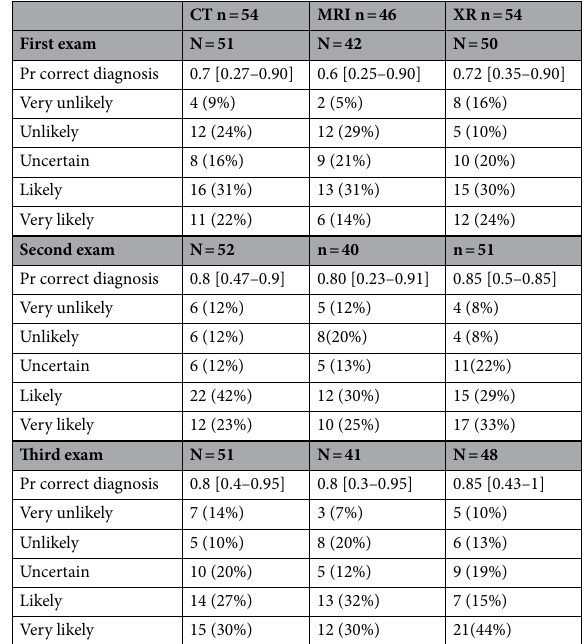
Table 2. Description of percentages of correct diagnoses over time according to the first imaging. CT Computed tomography, XR Standard radiograph, MRI Magnetic resonance imaging.